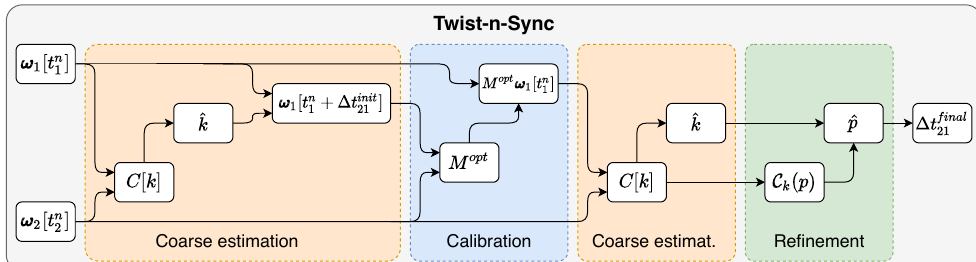
Figure 2. Twis-n-Sync algorithm diagram. The algorithm has raw angular velocity measurements from two rigidly attached gyroscopes as the input data and outputs an estimated offset between the timestamps of the measurements. The algorithm contains four stages: the first coarse estimation, calibration, the second coarse estimation, and refinement. If the sensors are previously calibrated, than two the first stages can be